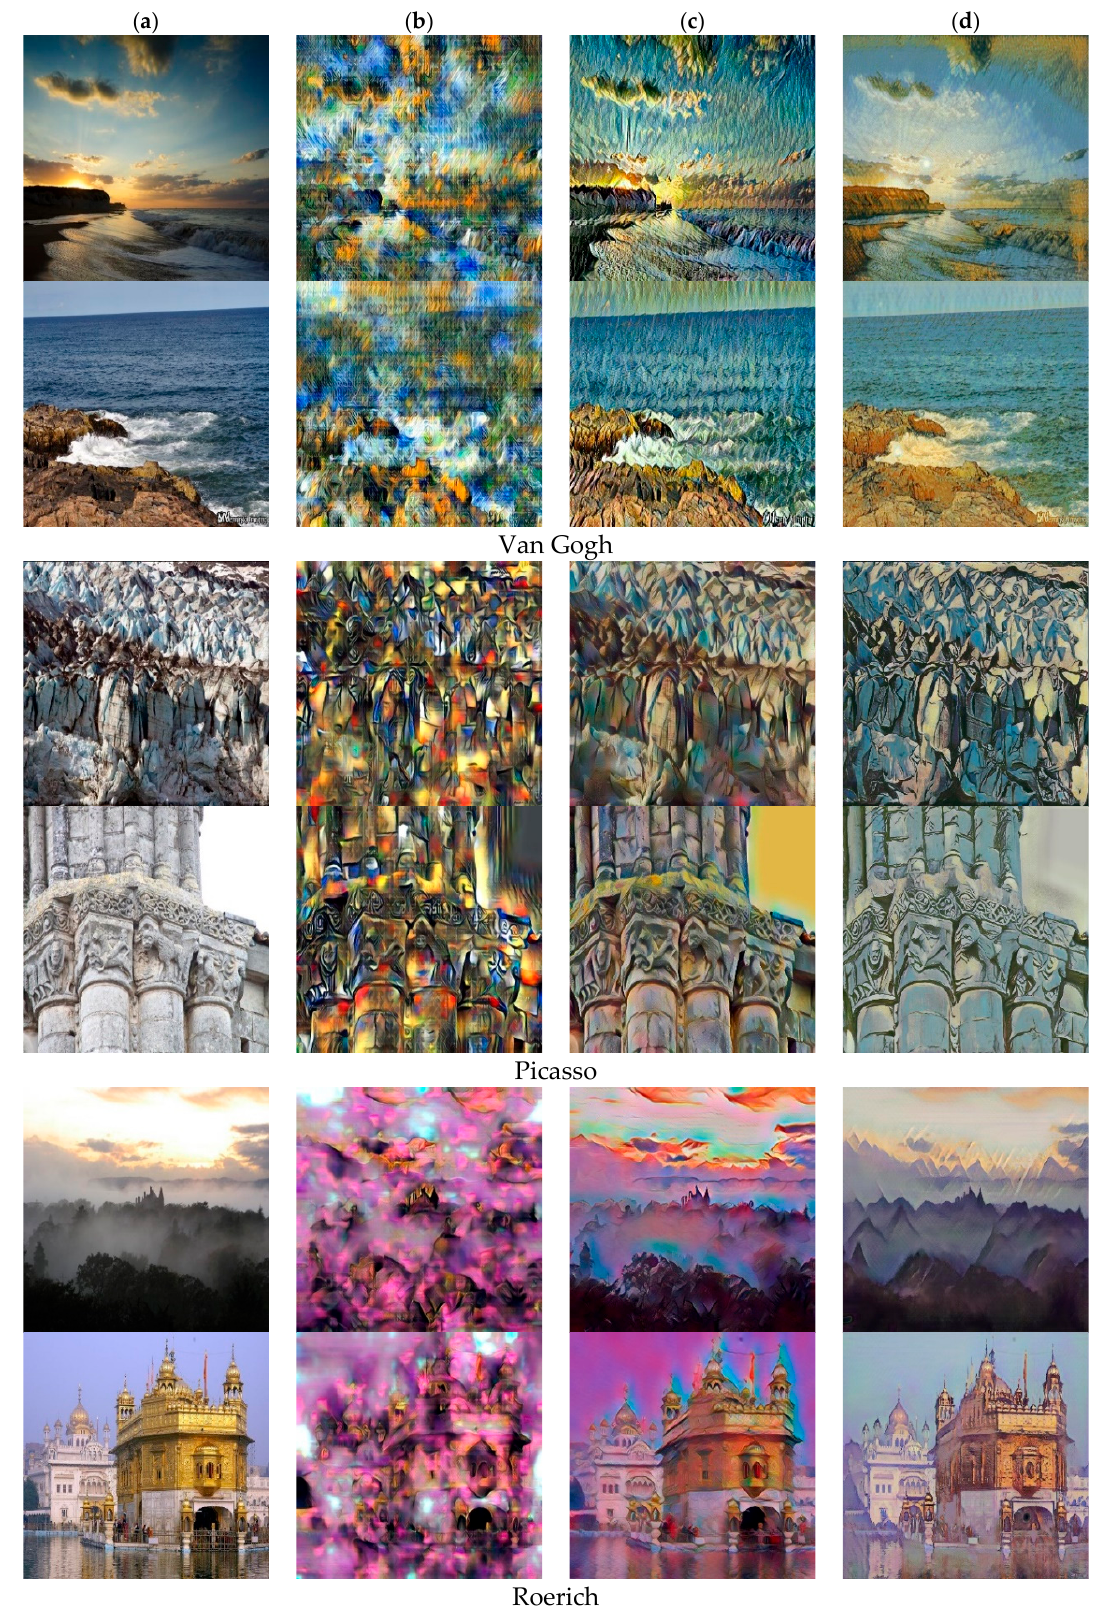
Figure 8. Comparison with the three styles of the zero-shot methods. ( a ) Inputs. ( b ) WCT [8]. ( c ) AdaIN [7]. ( d ) Ours.